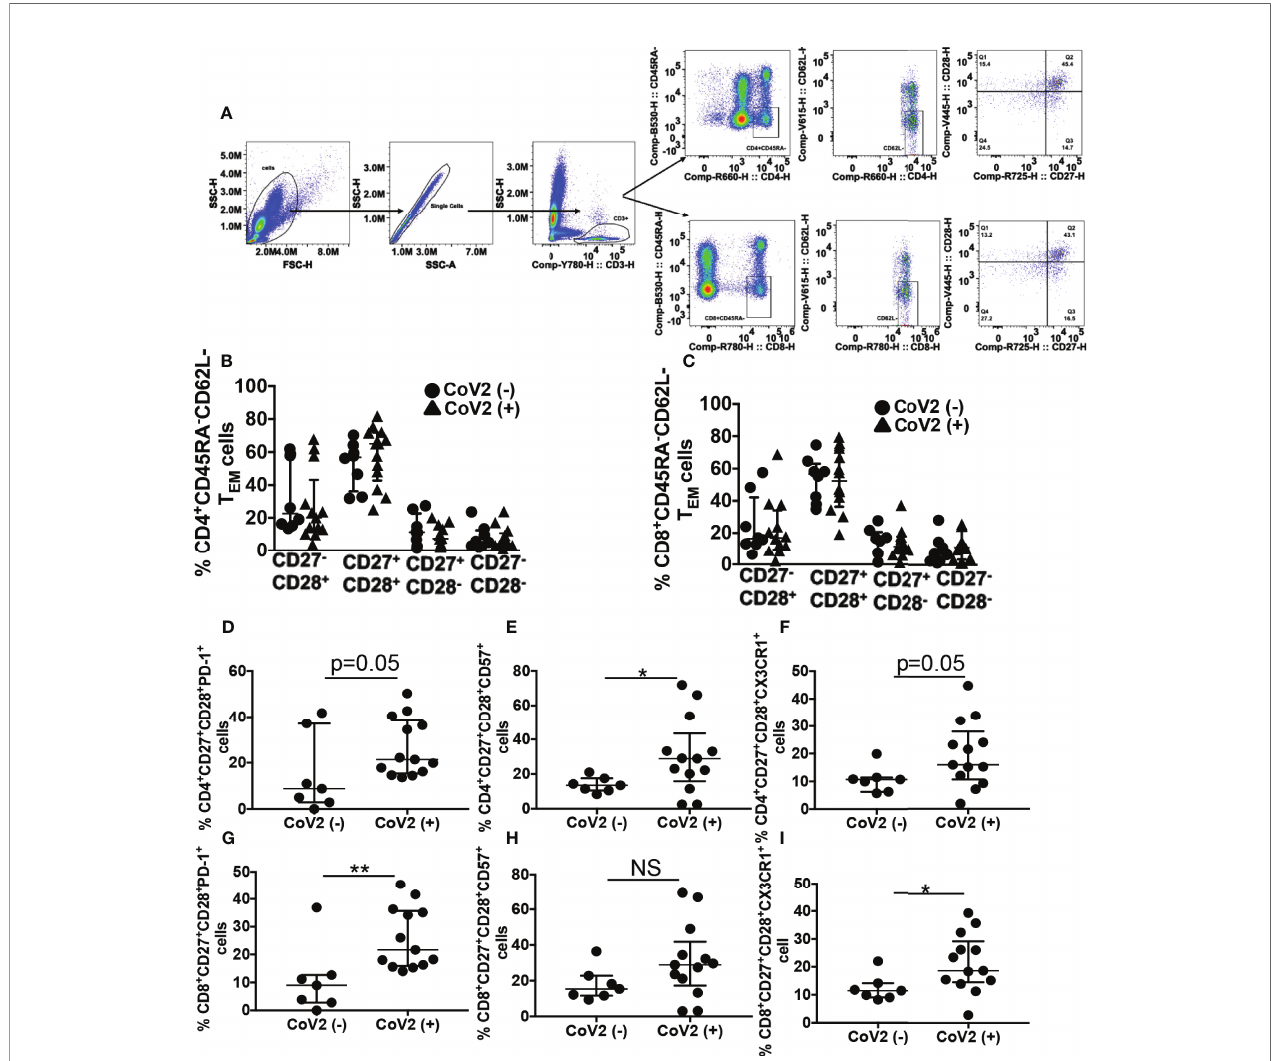
FIGURE 2 | CoV2+ individuals exhibit an aberrant T cell phenotype 5 months after the fi rst detection of infection: Heparinized blood obtained from CoV2- and CoV2+ individuals was stained with anti-CD3, -CD4, -CD8, -CD45RA, -CD62L, CD27, -CD28, -CD57, -PD-1 and -CX3CR1 antibodies. (A – C) Cells were analyzed for various T memory cell subsets as indicated. (A) Gating strategy for T cells is shown (B, C) Percentages of T memory cells are shown. (D – F) Percentages of PD-1 + , CD57 + and CX3CR1 + cells in CD3 + CD4 + CD45RA - CD62L - CD27 + CD28 + T memory cell subset (G – I) Percentages of PD-1 + , CD57 + and CX3CR1 + cells in CD3 + CD8 + CD45RA - CD62L - CD27 + CD28 + T memory cell subset is shown. For all, each dot in the plots depicts data of each individual donor, the plots include observations from 25 th to 75 th percentile. The horizontal line represents the median value. *p < 0.05; **p < 0.005 NS, Non-signi fi cant.